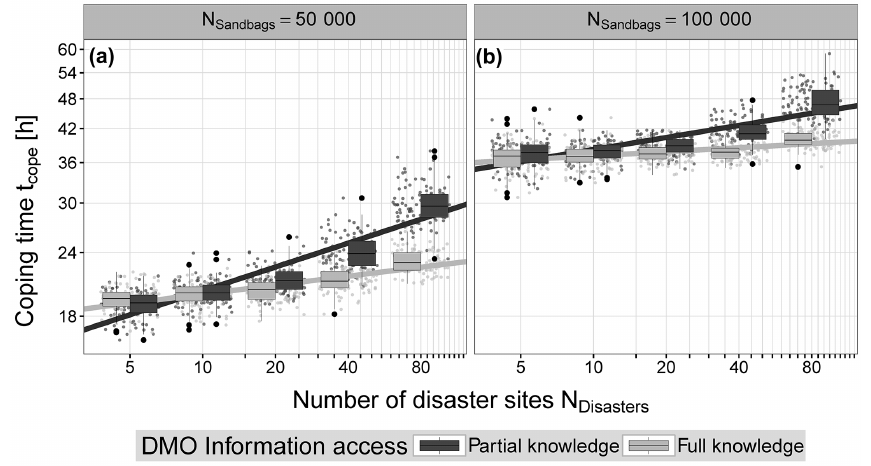
Figure 7. The distribution of coping time depending on flood characteristics: (i) the total demand of sandbags N Sandbags that need to be distributed ( a and b ), and (ii) the number of disaster sites N Disasters ( x axis). Results are additionally split by the information access of DMOs (dark grey / light grey). Dots represent results of single simulations, where overlapping dots result in darker colors, and superimposed box plots show the distribution of the results. Thick line shows the fitted power law. Results are presented on a double logarithmic scale. Results correspond to a setting with N DMO = 40 and a DMO capacity of 500